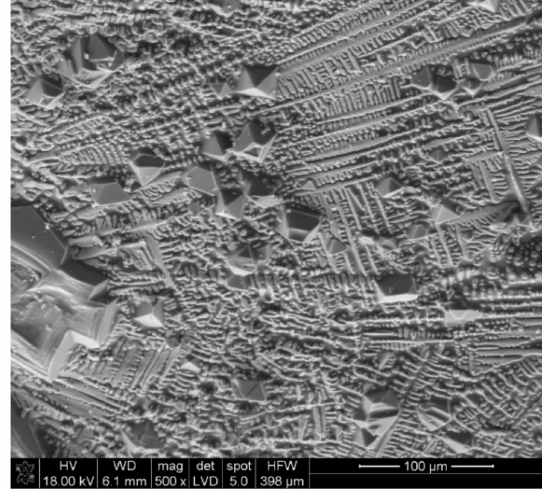
Figure 24. Sample BF1 with lower